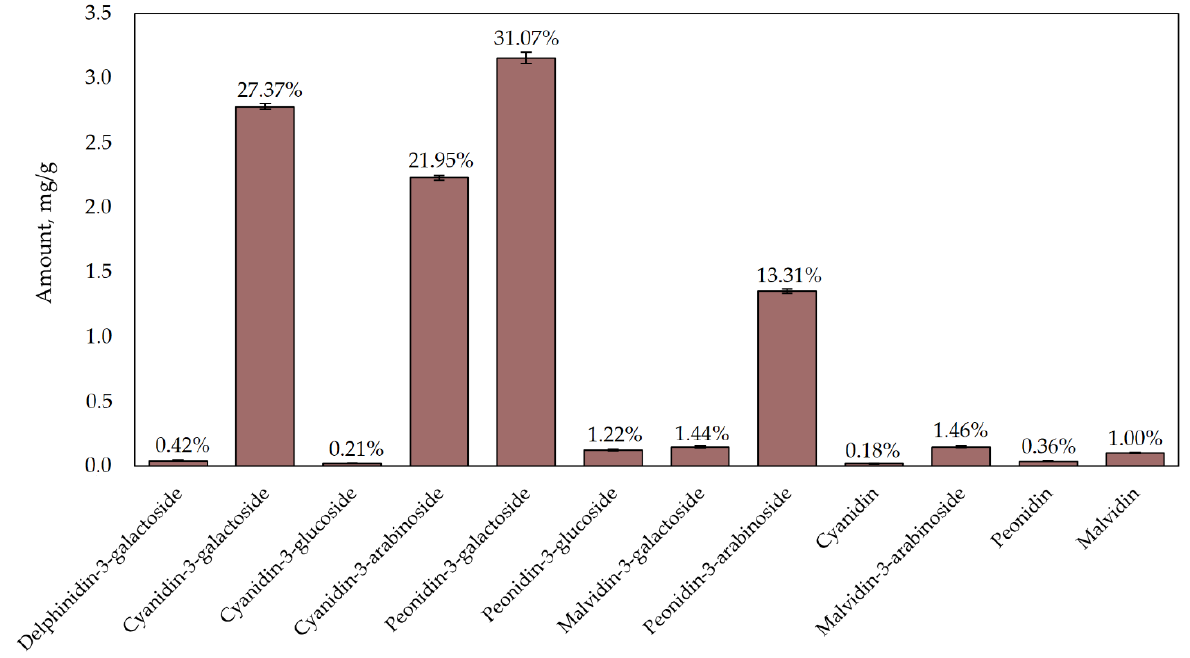
Table 1. Based on the anthocyanin content of the freeze-dried cranberry powder, we chose to use 0.200 g of freeze-dried cranberry powder per hard gelatin capsule. The encapsulated mixture contained a combination of microcrystalline cellulose and colloidal silicon dioxide (Prosolv) as a filler. Capsule formulations N2 to N4 contained between 0.025 g and 0.100 g of sodium carboxymethylcellulose, capsule formulations N5 to N7 contained between 0.025 g and 0.100 g of beta-cyclodextrin, and capsule formulations N8 to N10 contained between 0.025 g and 0.100 g of chitosan. In the manufacture of the encapsulated compound, sodium carboxymethylcellulose and chitosan were used as ingredients prolonging